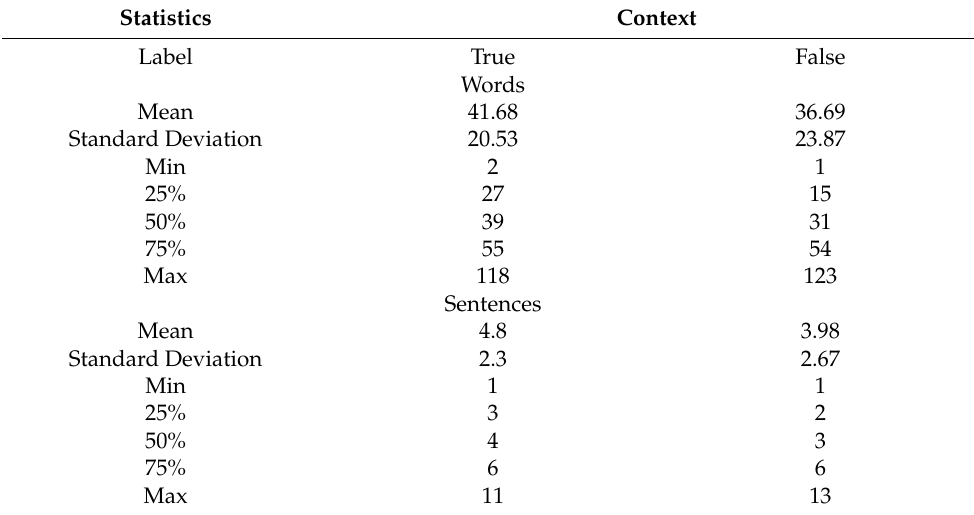
Table 2. General statistics of the context field, grouped by sarcasm.